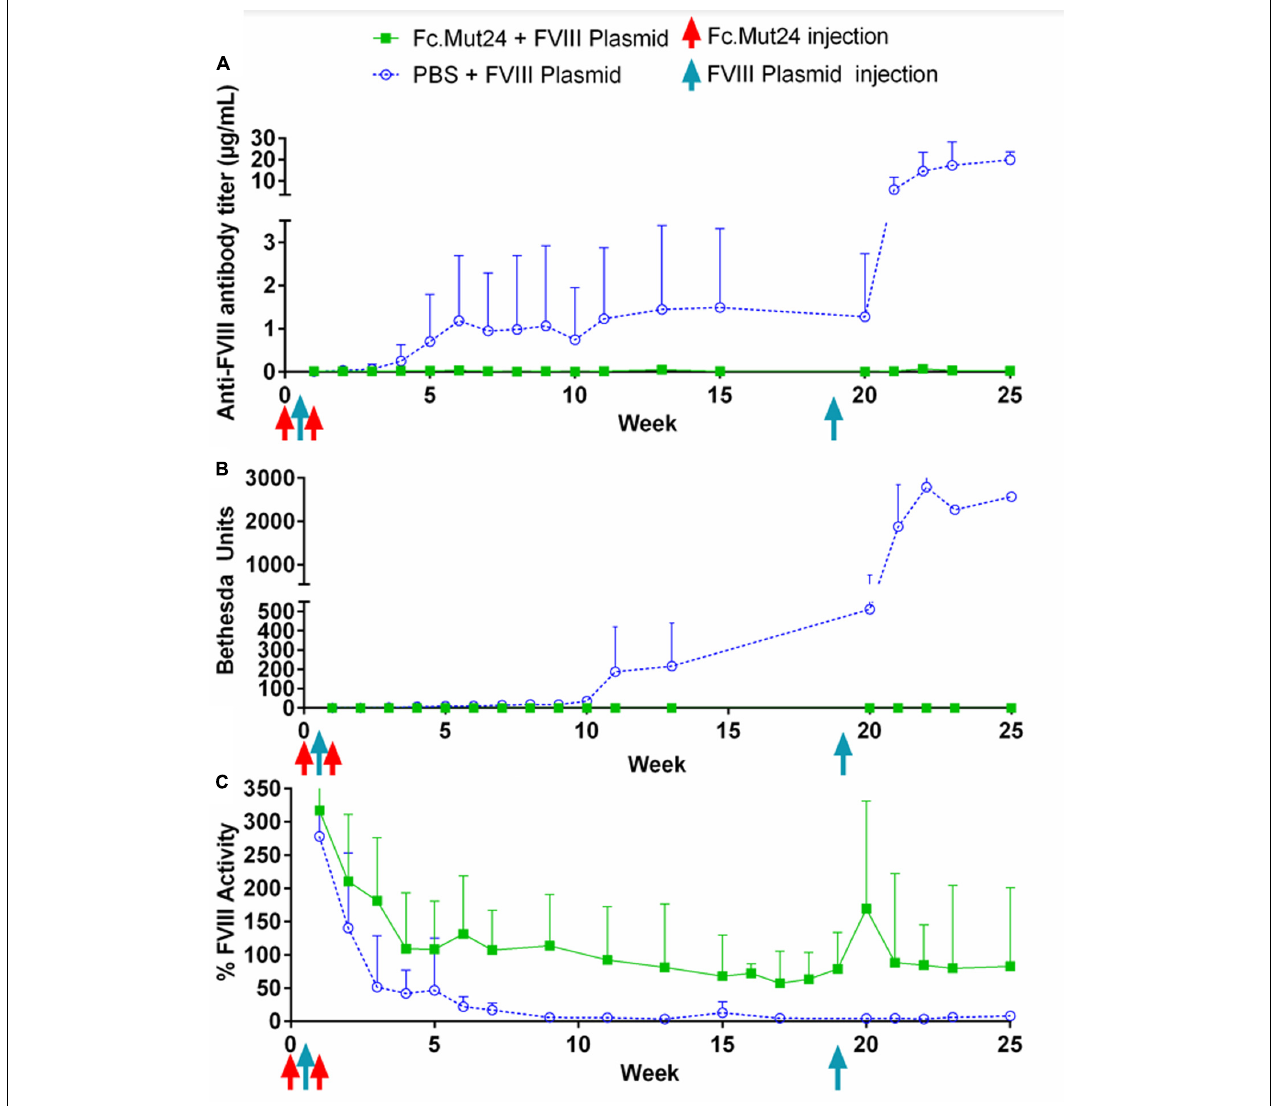
FIGURE 3 | Analysis of peripheral blood plasma of mice receiving Fc.Mut24 or PBS. Peripheral blood was collected via retro-orbital bleeding in sodium citrate and spun at 500 g for 5 min to separate plasma from cells. (A) ELISA was performed to measure anti-FVIII antibody levels in peripheral blood plasma using mouse whole IgG as control. p = 0.021 between Fc.Mut24-treated ( n = 8) and PBS-treated ( n = 4) groups. (B) Bethesda assay was performed on peripheral blood plasma. Serial dilutions were performed on plasma samples that showed high levels of inhibitor to obtain accurate inhibitor titers. p = 0.0092 between Fc.Mut24- and PBS-treated groups at multiple time points. (C) Factor VIII activity was measured in peripheral blood plasma via activated partial thromboplastin time assay relative to normal human plasma controls. p = 0.0014 between Fc.Mut24- and PBS-treated groups at multiple time points. The experiments were repeated twice with no significant variation. The data are presented as means with standard deviation. The p -values were calculated for multiple time points between groups using repeated-measures